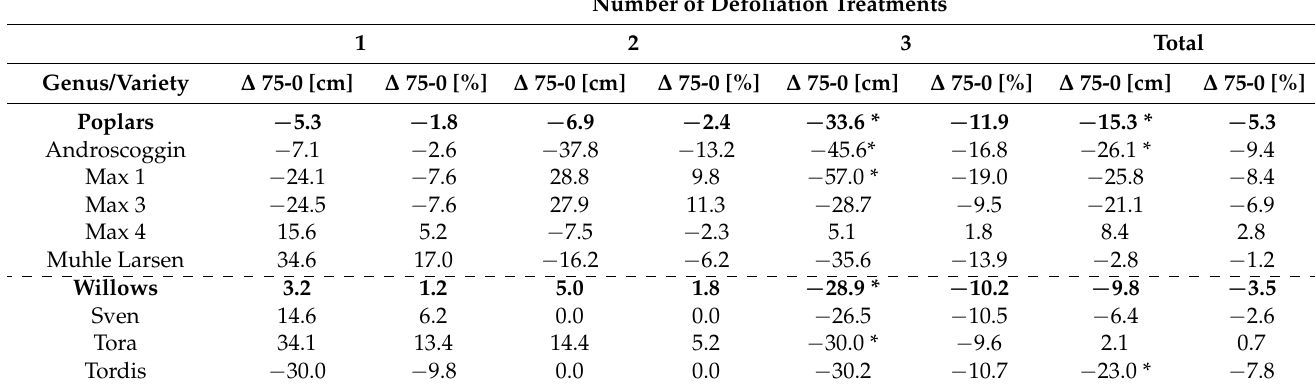
Table 9. Height differences of 75% defoliated and undefoliated plants ( ∆ 75-0) on the study site in Großthiemig in September 2009 after a harvest in March 2009 with regard to the number of defoliation treatments (* statistically significant difference according to the t